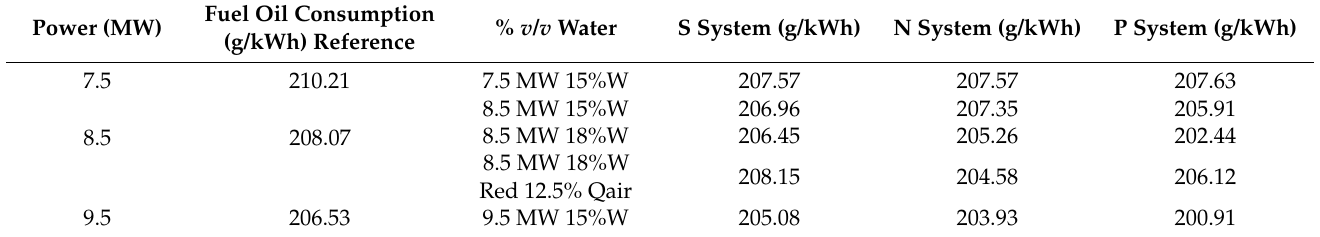
Table 8. Process model I.